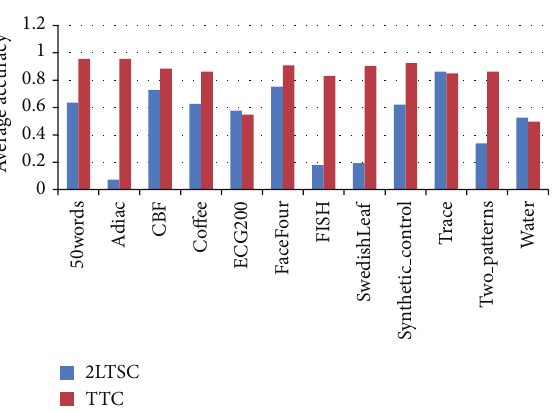
Figure 5: Comparison of 2LTSC and TTC against ground truth using the test datasets.